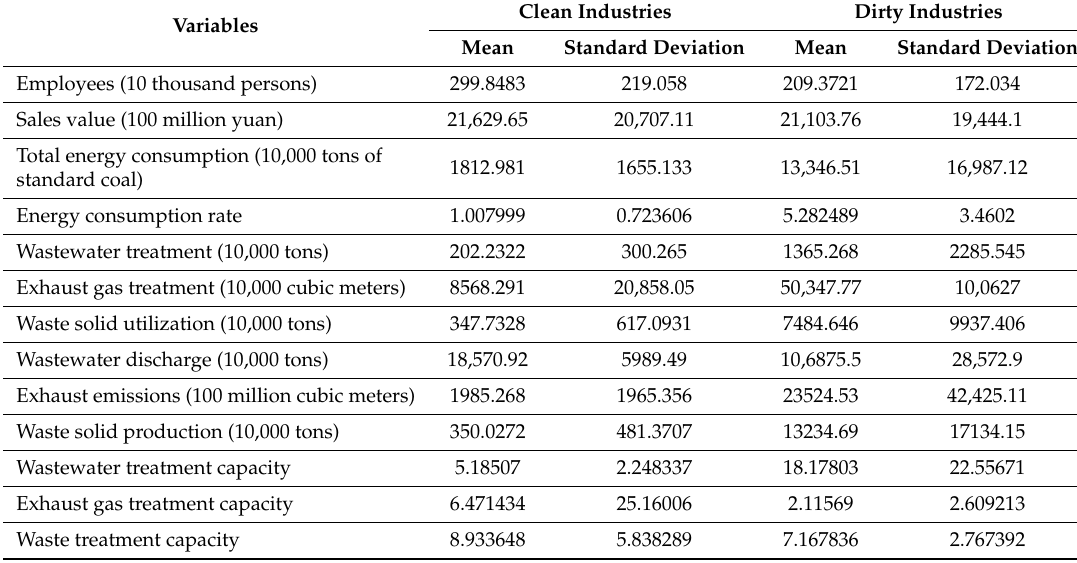
Table 3. Characters of clean industries and dirty industry.